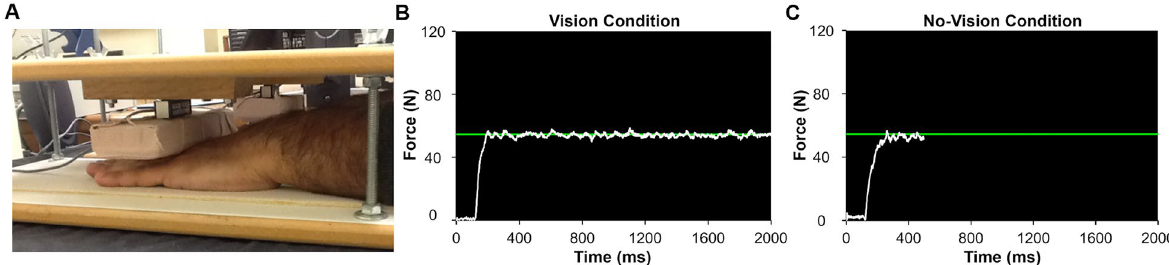
Figure 4. Experimental setup. ( A ) Bimanual force control tasks with wrist and fingers extension. ( B ) Visual feedback condition. ( C ) No-visual feedback